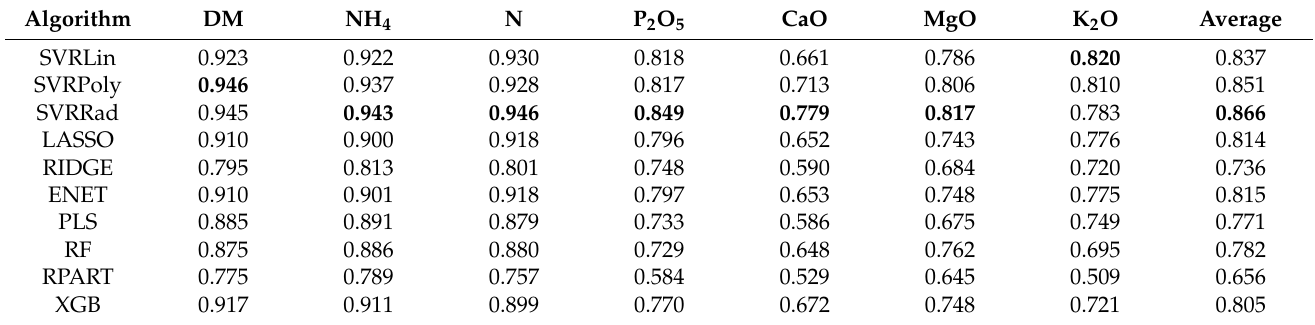
Table 5. Comparison of R 2 in the training set among the seven chemical components: dry